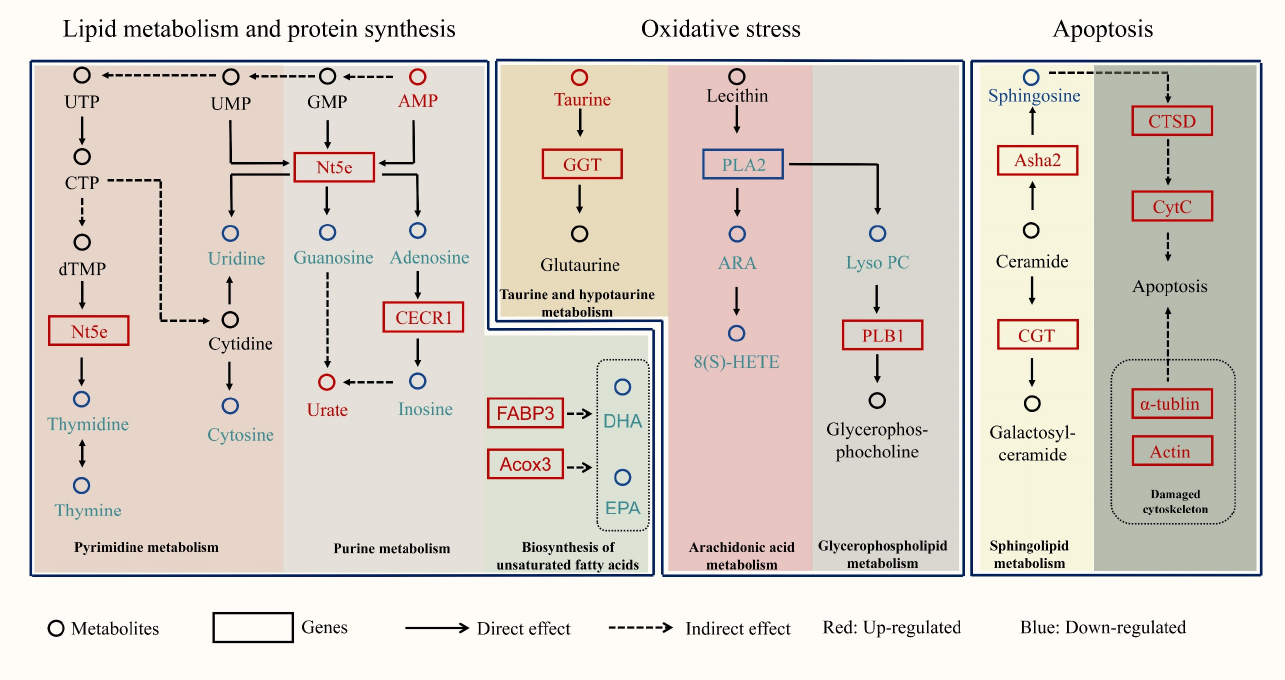
Figure 6. An integrative metabolic network map inferred from differential genes and metabolites between the SMF group and the SMS group identified by transcriptome and metabolome integration analysis. DEGs are indicated by boxes, among which red indicates up ‐ regulated genes and blue indicates down ‐ regulated genes in the SMF group. DMs are indicated by circles, among which red indicates up ‐ regulated metabolites and blue indicates down ‐ regulated metabolites in the SMF group. Abbreviations: UTP, Uridine ‐ 5’ ‐ triphosphate; CTP, Cytidine ‐ 5’ ‐ triphosphate; dTMP, deox ‐ ynucleotide; Nt5e, 5’ ‐ nucleotidase; UMP, uridylic acid; GMP, Guanosine monophosphate; AMP,